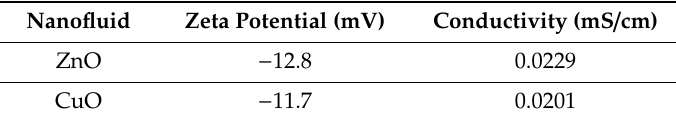
Table 2. Comparison of morphological parameters in 8 weeks old regenerants produced from shoots on the Murashige and Skoog (MS) medium supplemented with different concentrations of ZnO ENPs.